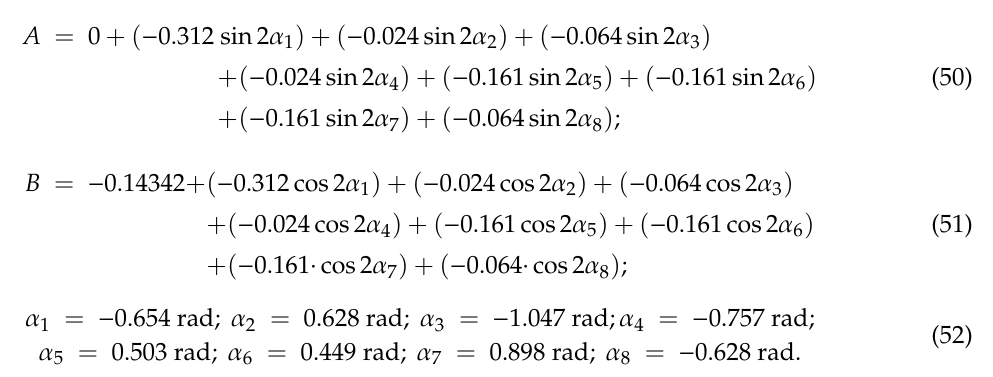
Table 9. Ratios of the modal participating mass after the reducing of the torsion.